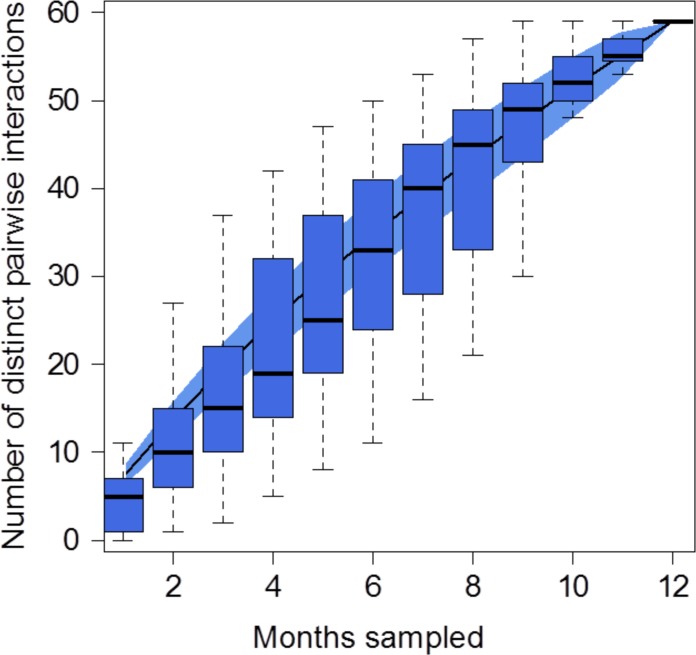
Completeness of the sampling of ant–diaspore interactions.Accumulation curves for distinct pairwise ant–diaspore interactions, recorded over 12 months in the Brazilian Savanna. The error bars represent the 95% confidence intervals.